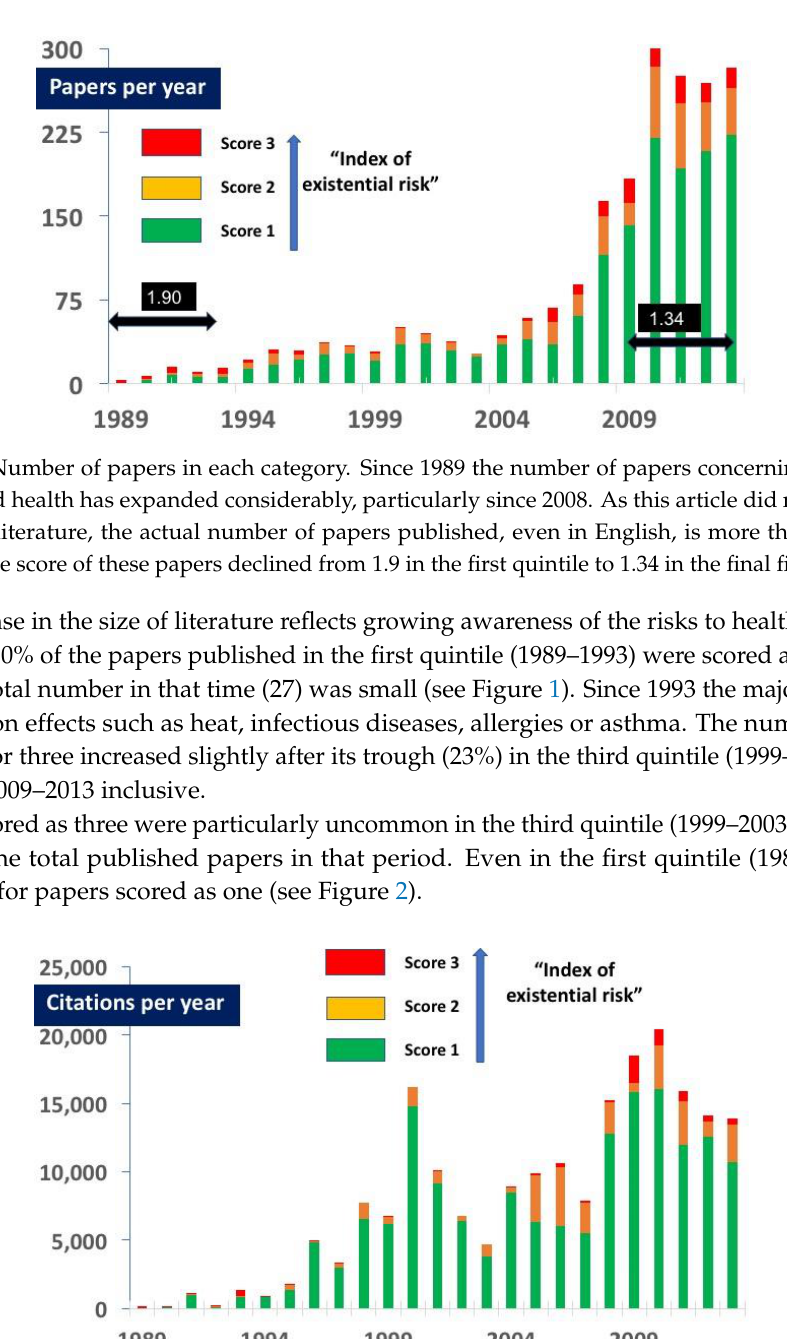
Figure 2. Number of citations per annum for each score of paper. Most citations were for papers scored as one. Note that in 2005–2007 three extensively cited papers were scored as two (these are discussed in the Appendix A).